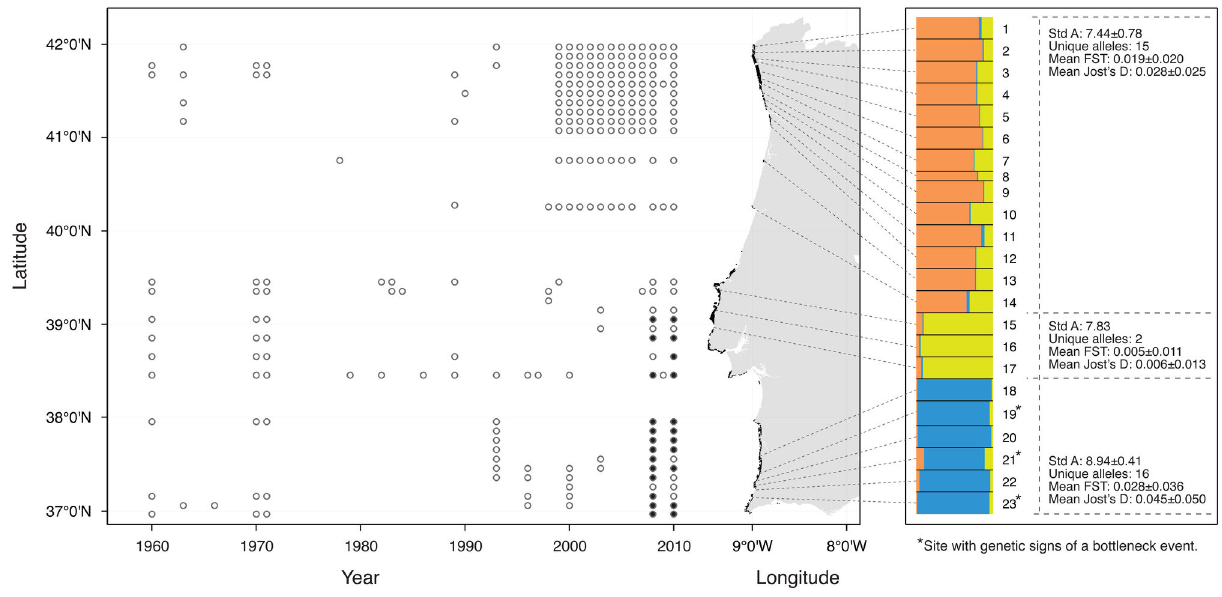
Figure 2. Historical distribution of S. polyschides based on surveys (2008 and 2010) and literature records (only comparable sites are shown; Open circle: presence, Black circle: absence). Habitat availability shown in black (Rocky reef; data from Portuguese sedimentary charts [70]) along the coast for depths above 20 m (the observed depth distribution of S. polyschides [92]). Genetic subdivision of S. polyschides based on STRUCTURE. The proportions of individual multilocus genotypes assigned to K=3 virtual clusters are indicated by the colours. Standardized allele richness (Std A), Mean F number of unique alleles per genetic